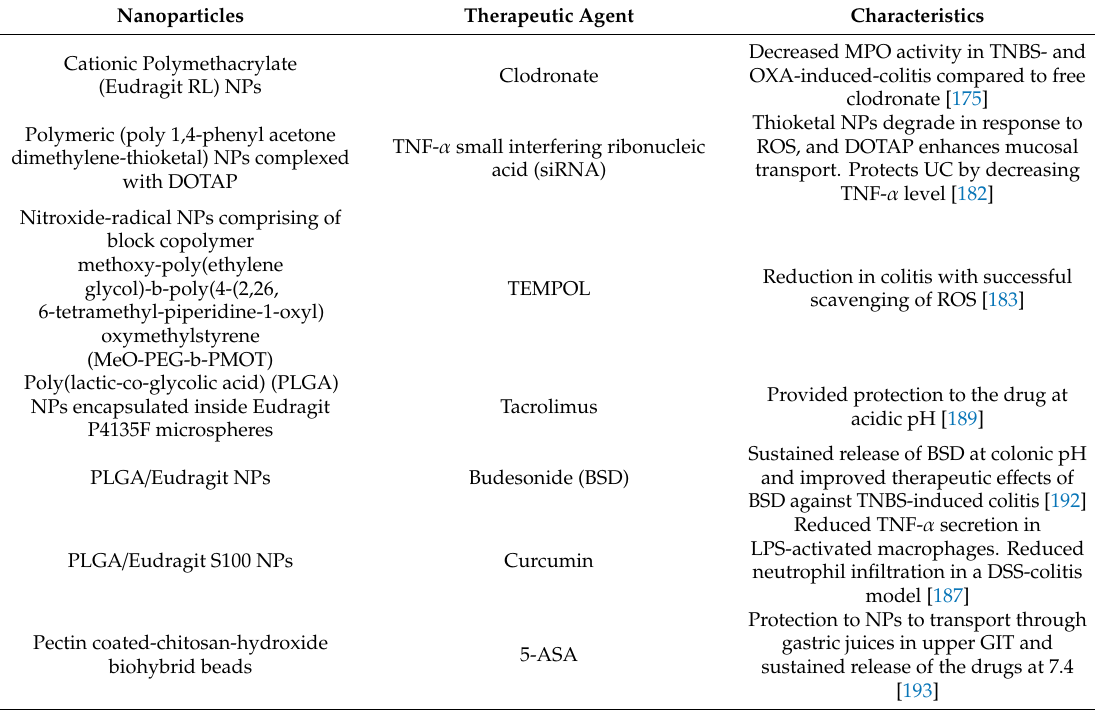
Table 2. Few examples of therapeutic nanoparticles / microparticles that have experimentally (in vitro, in vivo, and ex vivo conditions) used in the treatment of